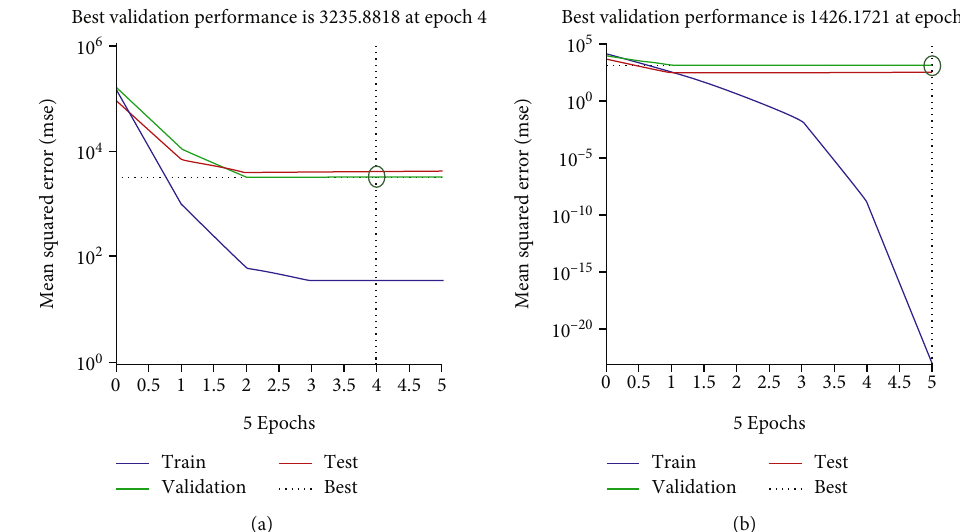
Figure 7: E ff ectiveness plots of (a) iodine and (b) methylene blue.